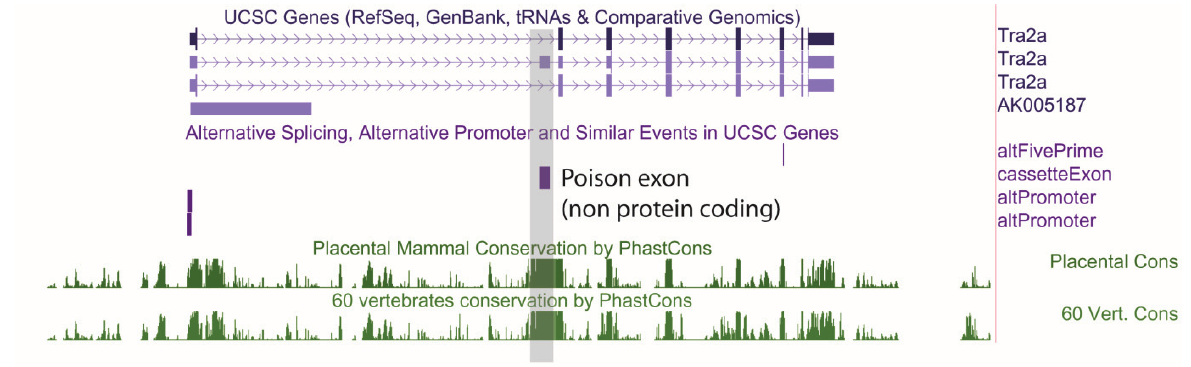
Figure 5. Non protein coding exons are conserved in the genome. Some non-coding exons are highly conserved in the human genome and play important roles in controlling the expression levels of splicing regulator proteins. The TRA2A gene encodes the splicing regulator protein Tra2α and contains a poison exon that contains multiple stop codons and is only inserted into some mRNAs. Despite not containing coding information, the TRA2A poison exon is highly conserved across species (indicated by the Phastcons score). Notice that the TRA2A gene encodes also alternative 5' splice sites and uses alternative promoters. This screenshot was downloaded from the UCSC genome browser